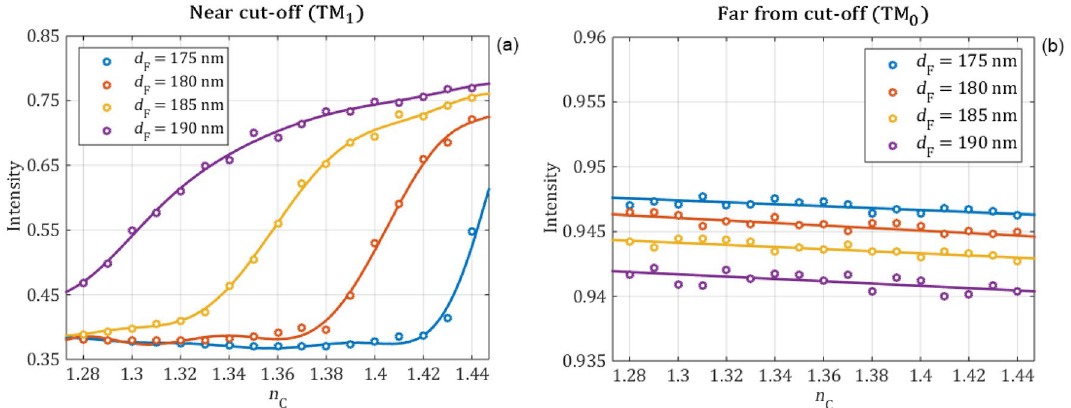
Figure 9. The intensity of the reflection peaks obtained from full wave electromagnetic simulations (circle markers) are fitted with polynomials (continuous curves) for the near cut-off ( a ) and far-from cut-off ( b ) modes in function of the refractive index of the cover media for different waveguide film thicknesses. Far from cut-off the cover refractive index negligibly influences the intensity, while near cut-off the intensity of the mode is highly influenced by the cover refractive index.